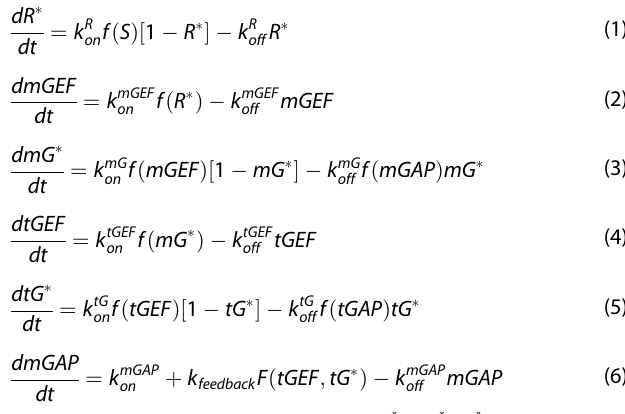
Fig. 1 Exploring mechanisms for improving DoRA through GTPases switches. a The schematic of dose-response alignment (upper panel) and misalignment (lower panel). Dose-response alignment refers to the close match of receptor occupancy and the downstream molecules, and the misalignment the far distance between receptor occupancy and the downstream molecules. b Comparing network architectures capable of perfect DoRA to the negative feedback with general kinetics. “ Perfect ” means the perfect match of receptor occupancy and the downstream molecules. The naturally reoccurring negative feedback does not have so many constraints as the fi rst three circuits, and we investigate how to improve misalignment to near-perfect DoRA in the circuit with negative feedback. c The experimentally identi fi ed coupled GTPase switches related to Arf1 (left) and the circuit without feedback (right). The adaptive response of Arf1 in 34 is achieved by the negative feedback loops from active tGTPase to mGAP and from tGEF to mGAP. It should be noted that the cross-talk between two negative feedback loops can be modeled using logical AND or OR operations. d The kinetic details that may affect DoRA, depending on modeling choices that are explored in this work. e Distance metric that measures the DoRA performance: the upper panel shows dose-response curves of the (red) and downstream GTPases mG (cid:1) and tG (cid:1) (blue: mGTPase; green: tGTPase); these curves after fractional activation for receptors R (cid:1) ss ss ss = R (cid:1) and Y ss / Y ss , max , normalization by their activation levels (de fi ned as the level when the stimulus goes to in fi nity) are denoted by R (cid:1) ss ss ; max Y = mG * , tG * , as shown in the middle panel; the lower panel de fi nes the distance metric as the weighted sum of the distance between = R (cid:1) = R (cid:1) R (cid:1) and Y ss / Y ss , max . This metric is equal to the area between the Y ss / Y ss , max and the diagonal line in the plot Y ss / Y ss , max vs R (cid:1) . The ss ss ; max ss ss ; max smaller value of this metric indicates better DoRA: zero means perfect DoRA, and small but non-zero value indicates a good